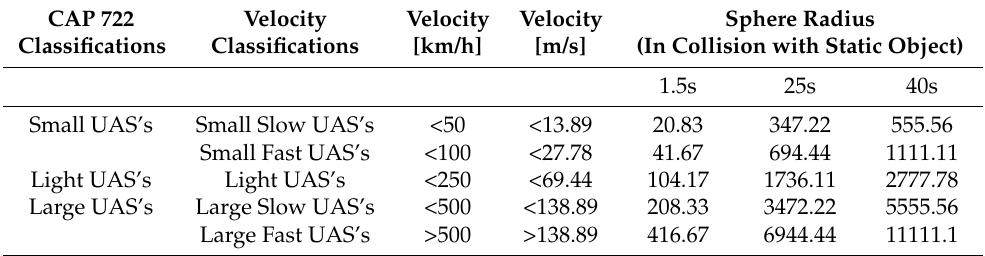
Table 1. UAS’s (Unmanned Aerial Systems) classifications, based on velocity.